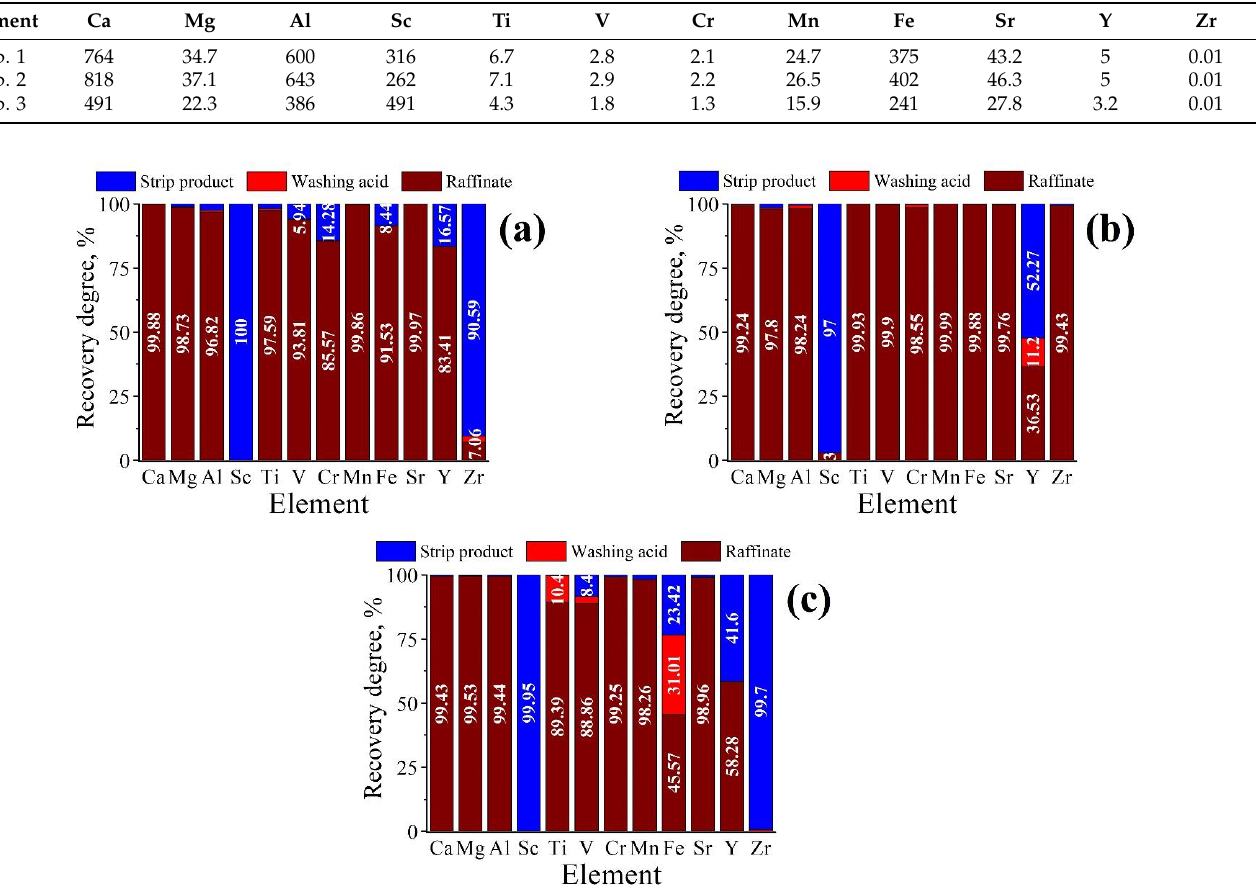
Table 7. The chemical composition of the prepared solutions for Sc solvent extraction, mg/L.